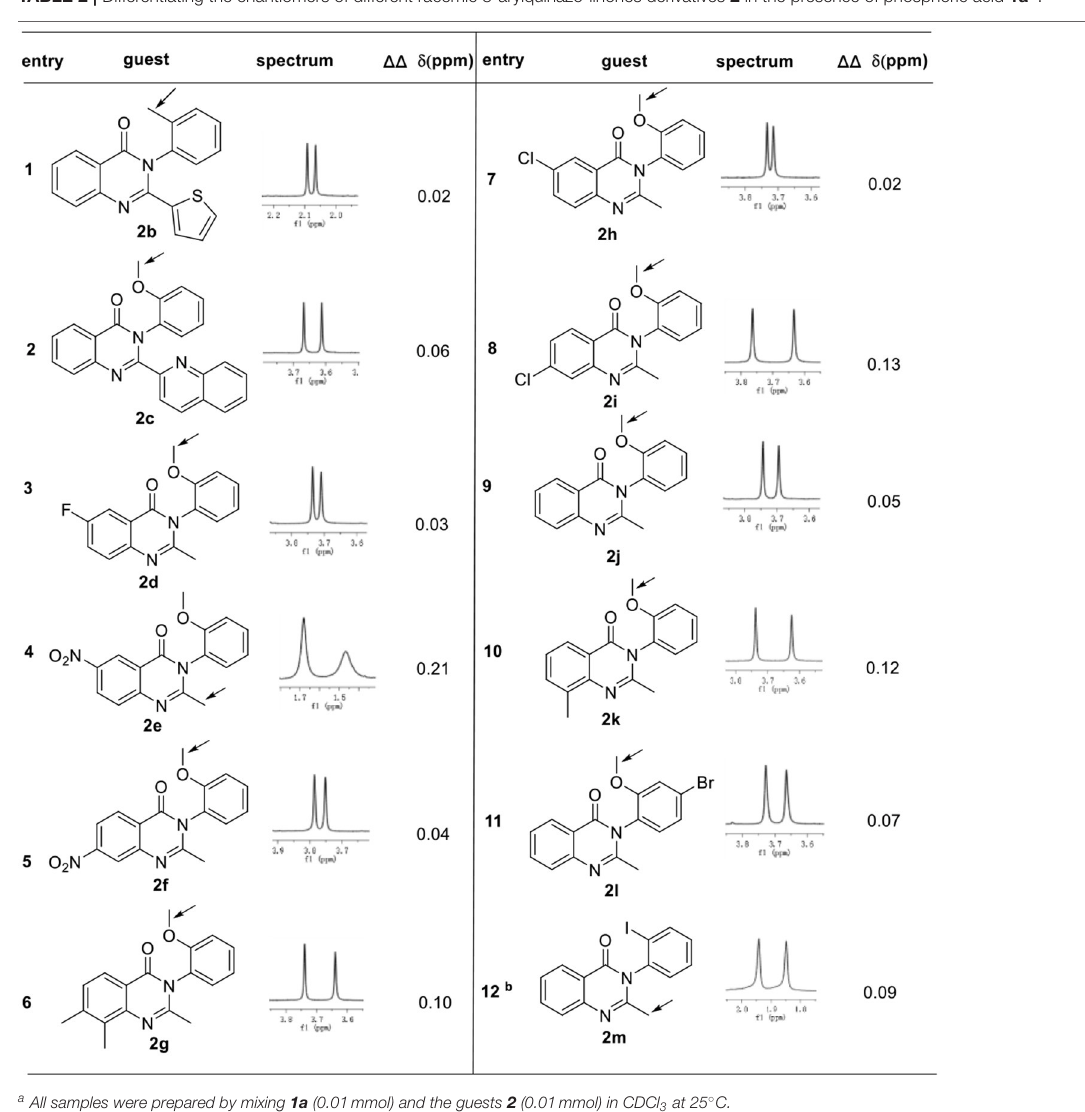
Frontiers in Chemistry |